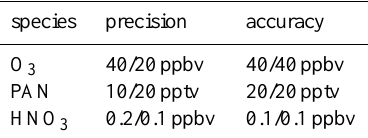
Table 1. Approximate precision and accuracy for discussed species as derived by linear diagnostics (Rodgers, 2000). The first number refers to values retrieved at instrument altitude, while the second number refers to values at altitudes ≈ 8km below the